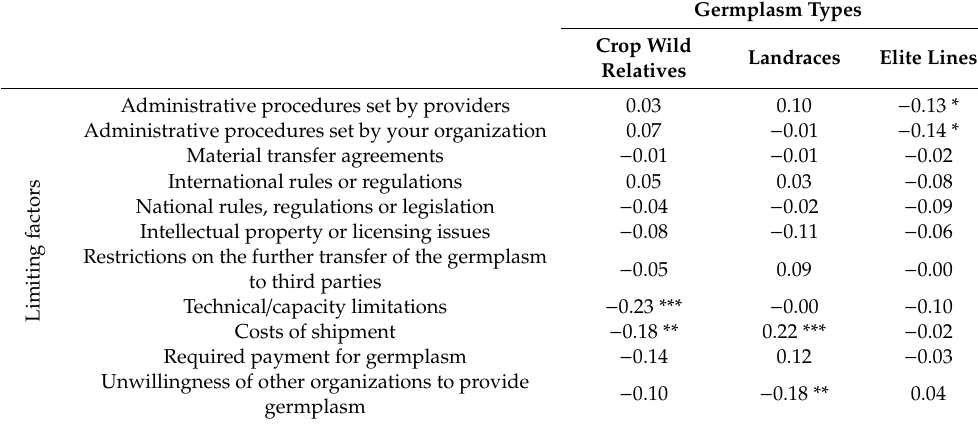
Table 6. Association between limiting factors and changes in the use of germplasm types.